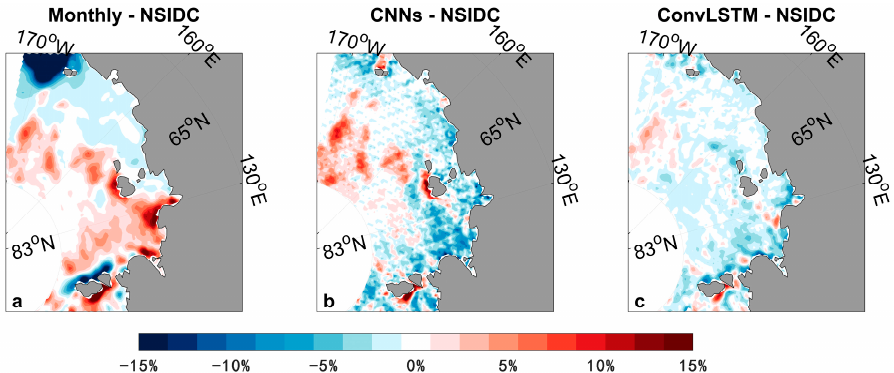
Figure 9. Comparison of the anomalies between different results, namely, monthly average ( a ), CNNs daily prediction ( b ), and ConvLSTM daily prediction ( c ) w.r.t the NSIDC SIC near the Eastern Siberia sea area. The meanings of each color in this figure are the same as those in Figure 8.